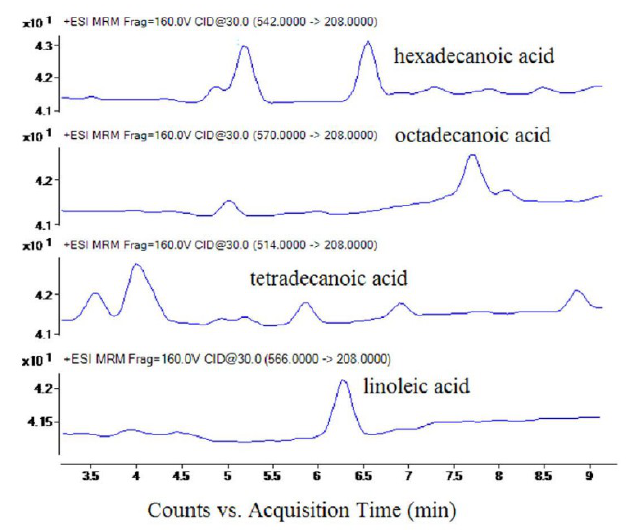
Figure 9. LC-MS/MS chromatograms of 10-methyl-acridone-2-sulfonohydrazide (MASH)-derivatized Figure 9. LC-MS / MS chromatograms of 10-methyl-acridone-2-sulfonohydrazide (MASH)-derivatized PFCAs in serum samples. [64]—Reproduced with the permission of Elsevier. PFCAs in serum samples. [55]—Reproduced with the permission of Elsevier. Table 4. Analytical methods for perfluorinated carboxylic acids (PFCAs) in biological samples.